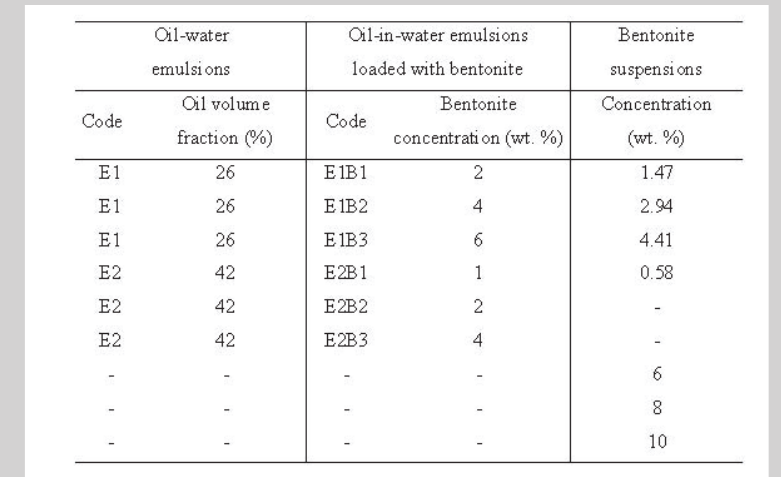
Table 1: Composition of the different systems